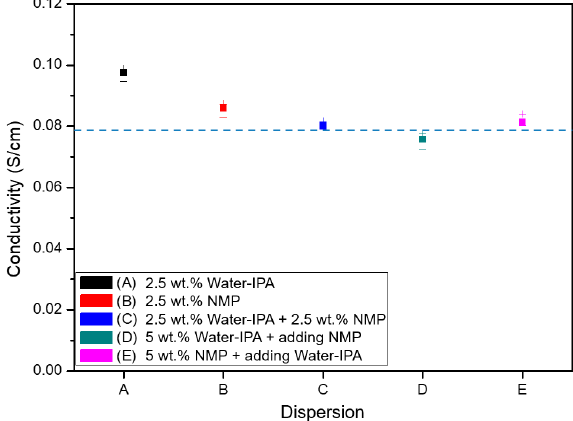
Figure 1. In-plane proton conductivity of the membranes cast from the five different ionomer dispersions prepared in this study (the dotted line represents the in-plane proton conductivity of Nafion 212).